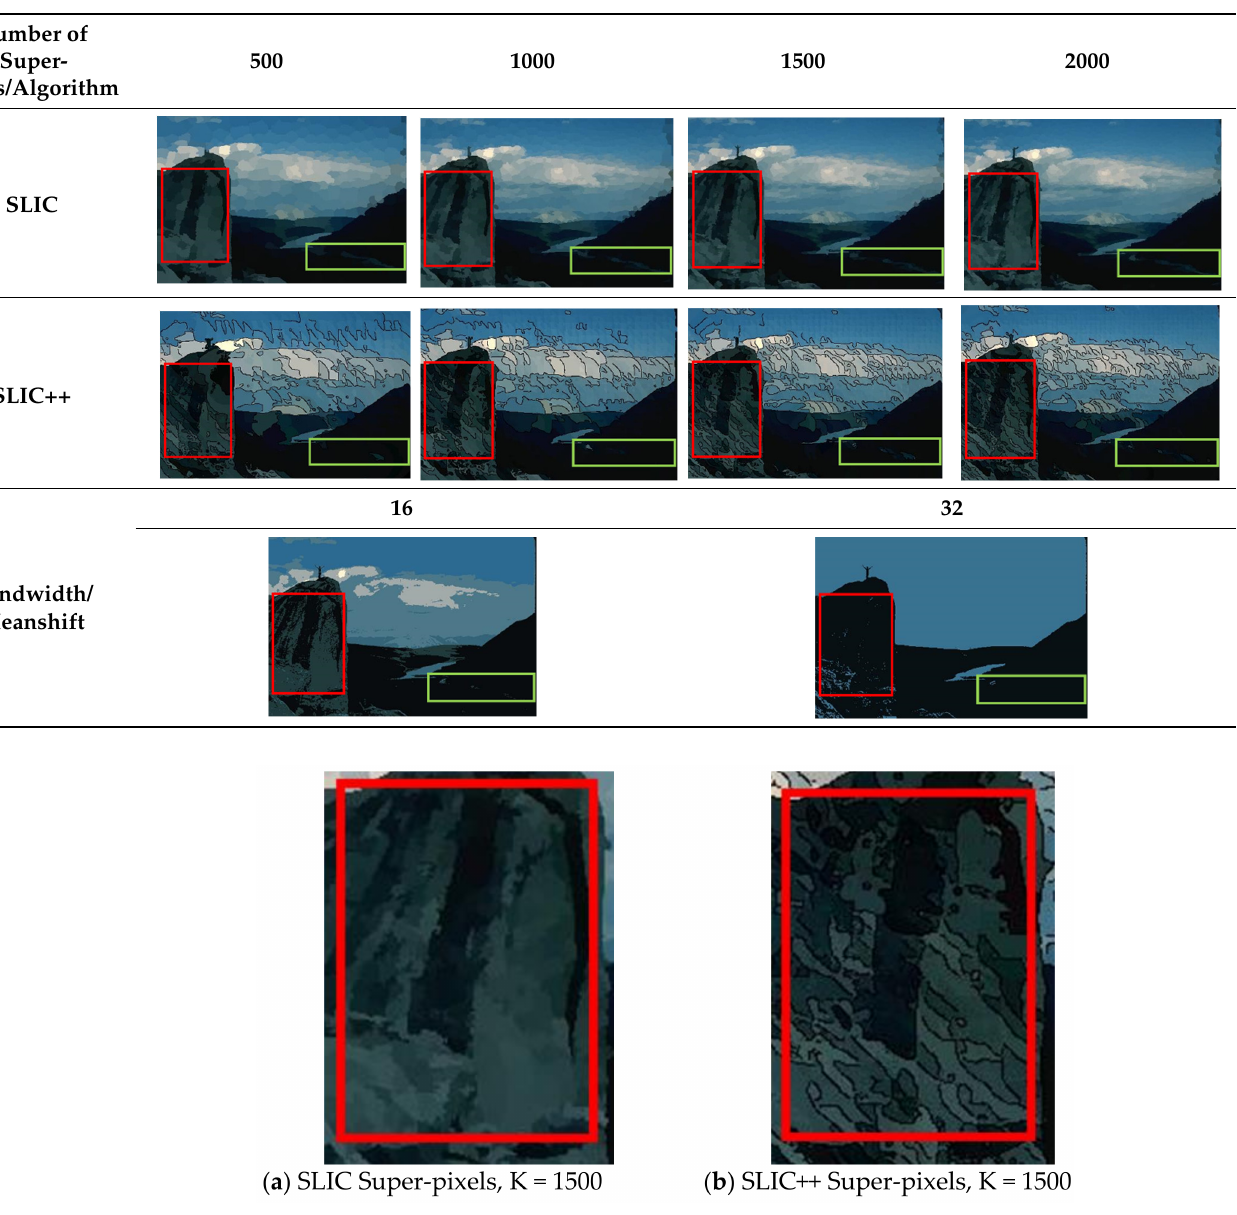
Figure 5. Zoomed in view of test case image for content-aware super-pixel analysis created by SLIC++ ( b ) against SLIC ( a ).